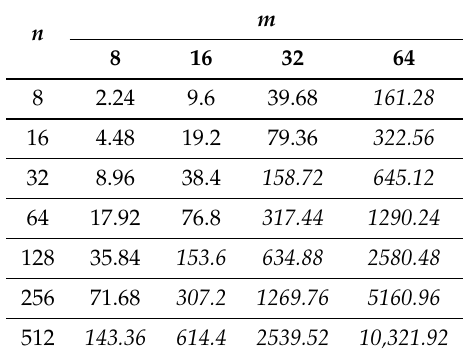
Table 3. λ values for multiple values of n and m with α 1 = 0.01. Values of n and m are highlighted in italics from which λ > λ 0 = 105. m n 8 16